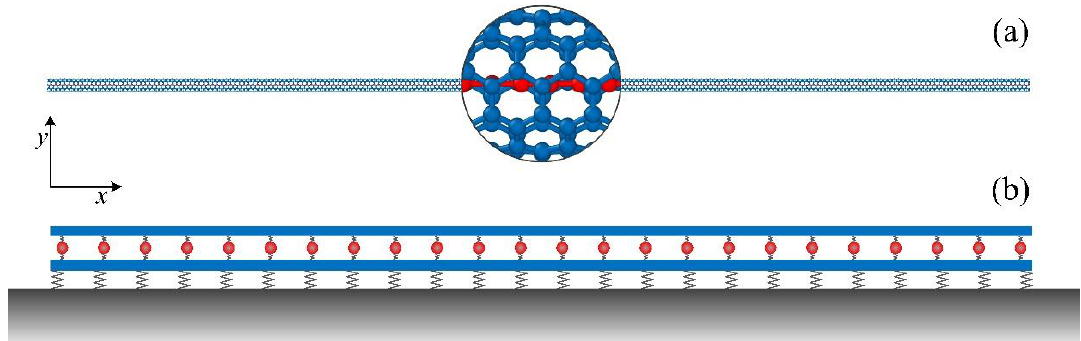
Figure 1. The mass chain-filled single-walled carbon nanotubes (SWCNTs) system. ( a ) Molecular structure model of a carbon-atom chain in a (5, 5) SWCNT; ( b ) continuum model of a mass chain-filled single-walled carbon nanotube (MCSC) system embedded in an elastic medium, the hollow cylindrical beam in blue is the equivalent model of a SWCNT.